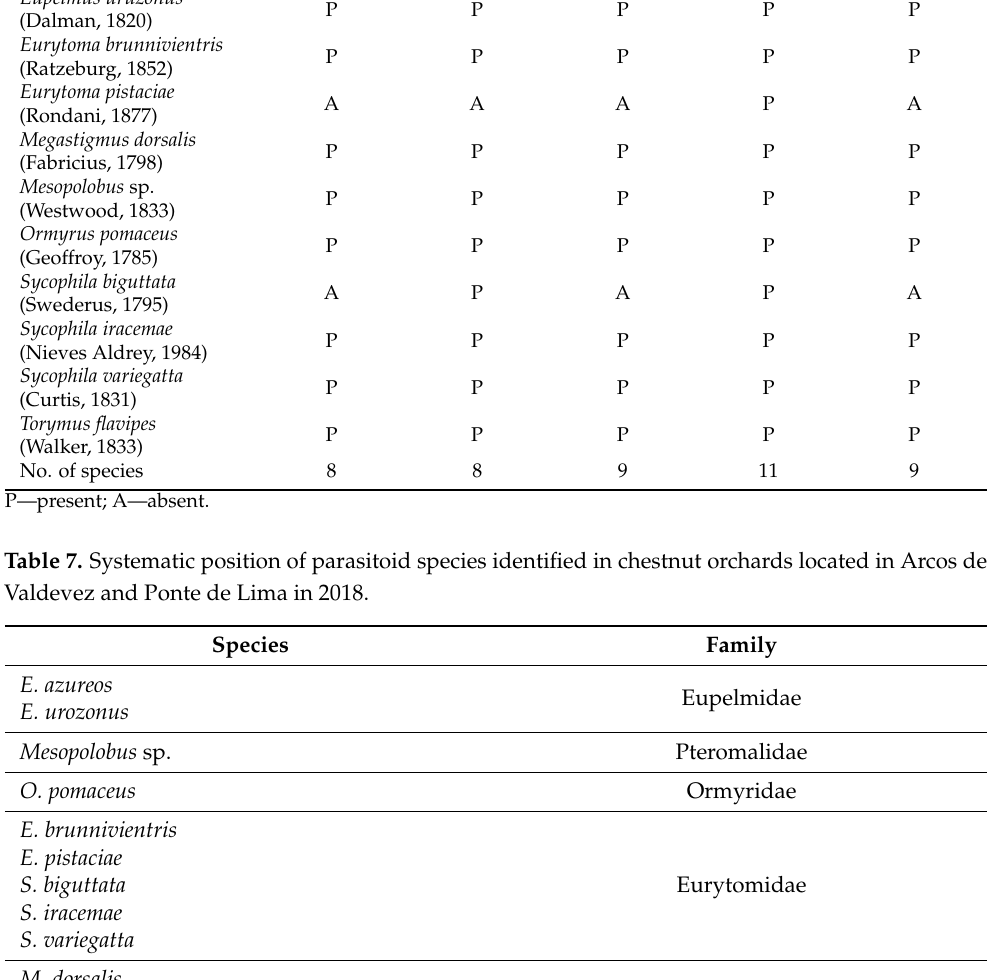
Table 6. Identification of native parasitoids in orchards located in Arcos de Valdevez (AVV) and Ponte de Lima (PTL), with one (1T), two (2T) or no treatment (NT) of T. sinensis in 2018. Parasitoid Native Chestnut Orchards Species P1AVV-2T P2AVV-2T P3AVV1T P4AVV-NT P5PTL-2T